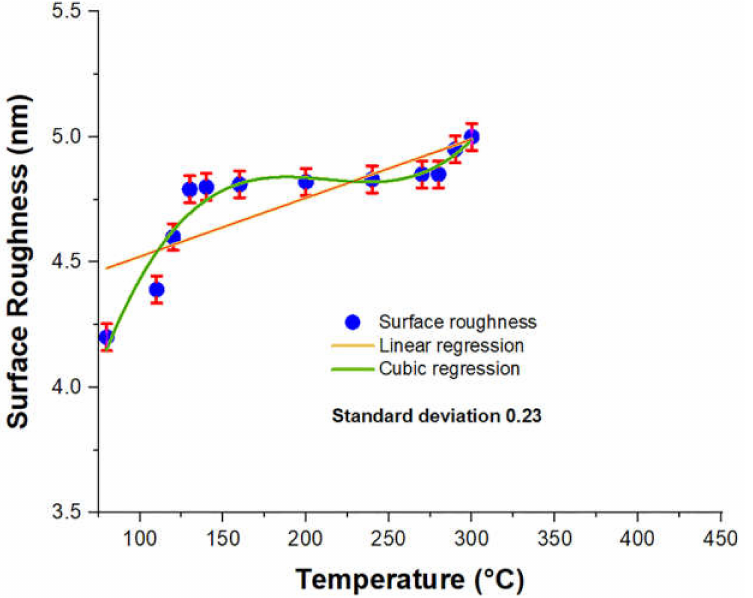
Figure 8. The error bars of the investigated data with the predicted data by the linear (orange) and cubic (green) regressions.